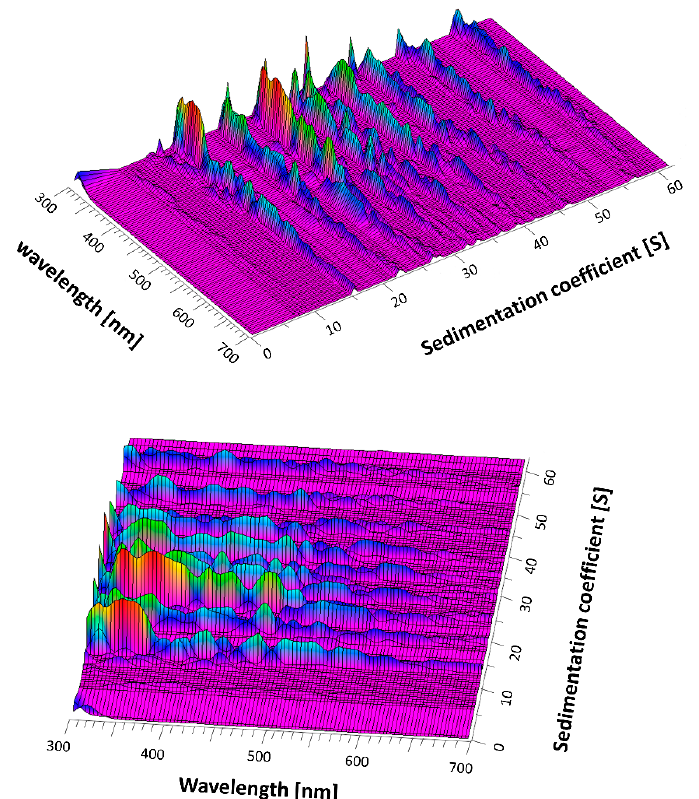
Figure 3 : 3D plot of the multiwavelength analysis of a band forming experiment of gold clusters (exp A-3). The plot is shown from two different viewpoints. The species are plotted versus the wavelength and discrete cluster species are determined.